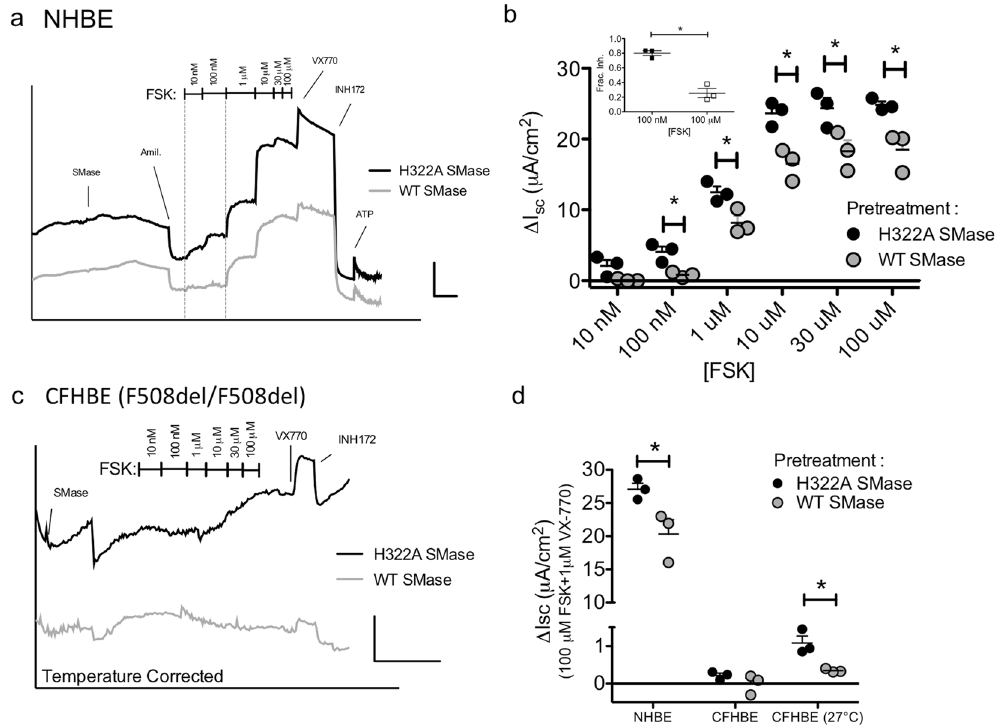
Figure 8. Basolateral treatment with SMase diminishes transepithelial currents in HBEs: ( a ) An example trace showing that pretreatment with basolateral WT SMase diminishes FSK-stimulated transepithelial currents in HBEs expressing WT CFTR. Scale bars: 10 μ A/cm 2 , 10 mins. ( b ) Summary data showing significant difference in current amplitudes following basolateral WT SMase (p < 0.0001 for FSK and SMase treatments, 2-way ANOVA; asterisks indicate p < 0.05 for subsequent pairwise t-test analyses). Inset- Fractional inhibition is significantly higher in the presence of 100 nM FSK than 100 μ M FSK (p = 0.0016, t-test). ( c ) An example trace showing that pretreatment of temperature-corrected CFHBEs with basolateral SMase leads to a similar reduction in maximal current. Scale bars: 2 μ A/cm 2 , 20 mins. ( d ) Summary data showing that basolateral treatment with WT